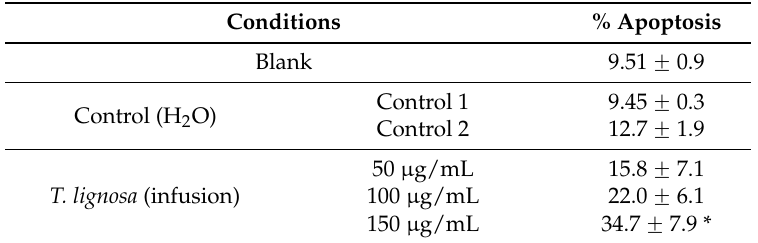
Table 2. Apoptosis levels in NCI-H460 cells treated with infusion extract of T. lignosa .